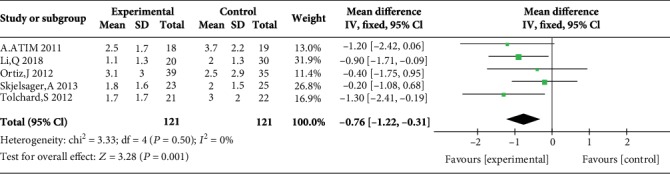
Postoperative pain scores at rest at 2 h.